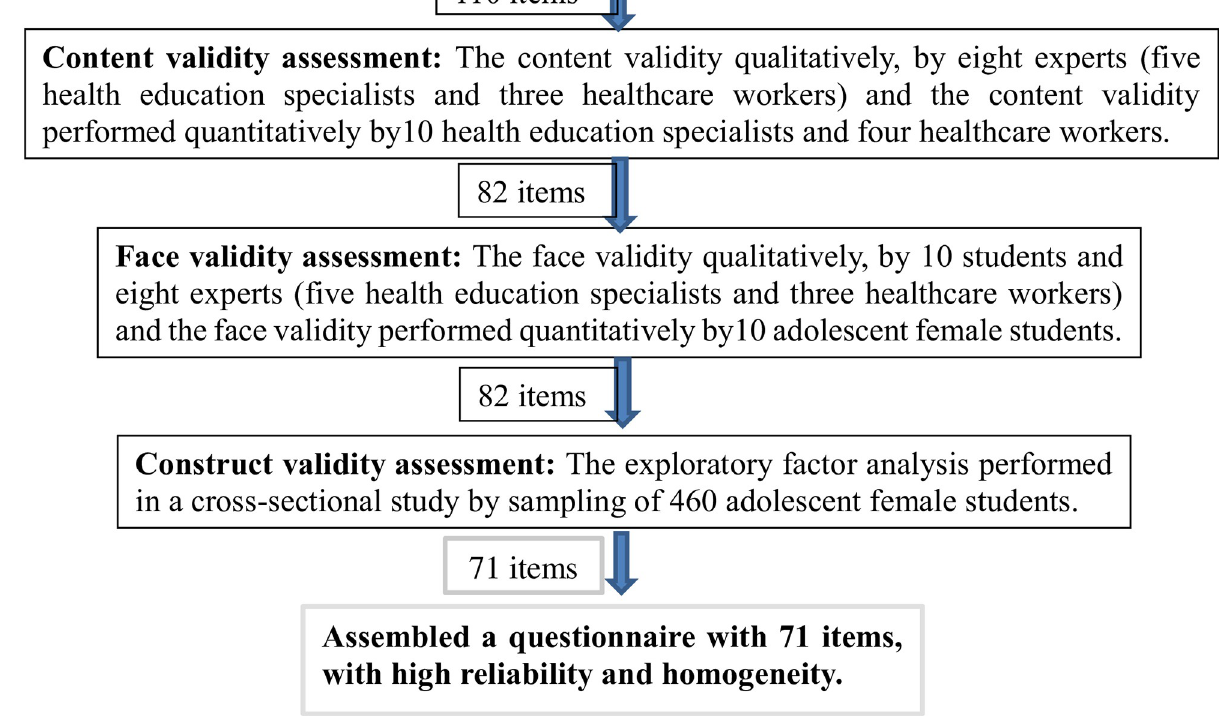
Fig 2. Stages of development and psychometric assessment of cutaneous leishmaniasis prevention behaviors questionnaire.